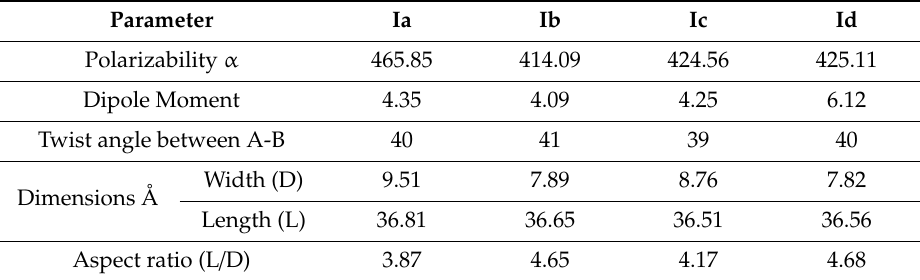
Table 2. Parameters (Hartree / Particle) and dipole moment (Debye) of